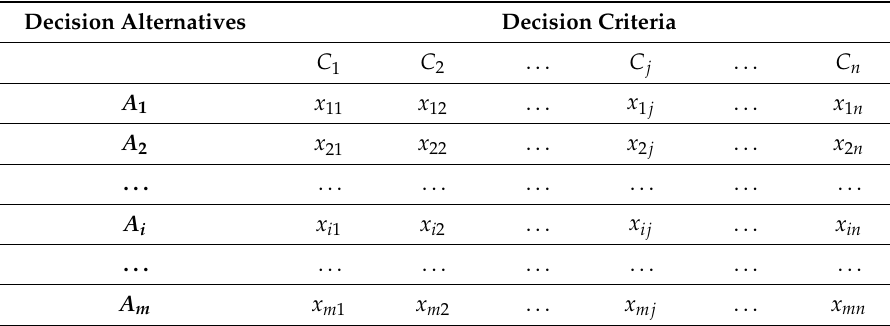
Table 4. Decision Matrix